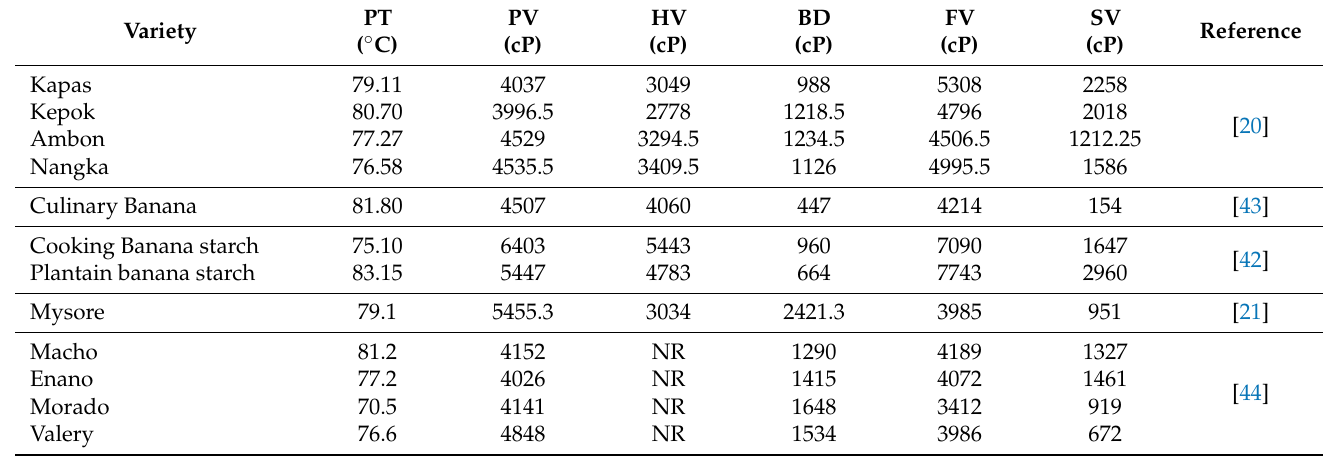
Table 3. The pasting properties of banana starch from various